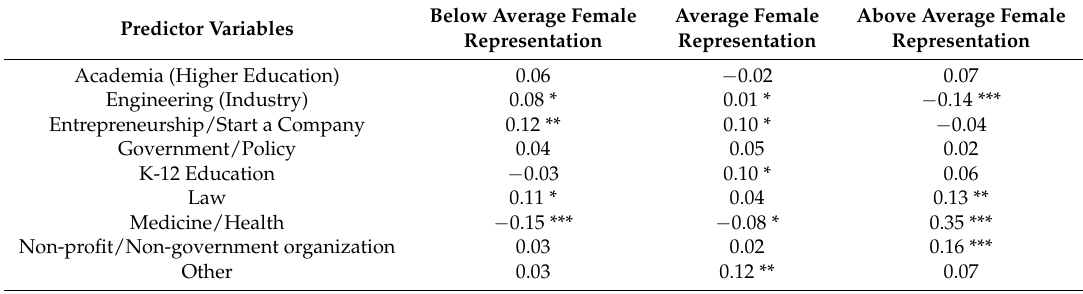
Table 5. Standardized Estimates of Multiple Regression Analysis for Career Aspirations in the Following. Predictor